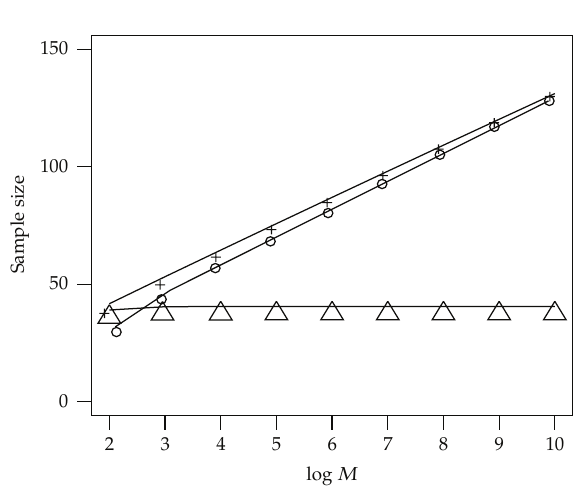
Figure 4: Sample size versus log M (cid:5) base 10 (cid:6) for controlling FDR f (cid:8) 5% with Ψ (cid:8) 90%. The open circles represent the sample sizes needed when the number of true alternatives m 1 stays as constant (cid:5) m 1 (cid:8) 40 (cid:6) , the plus signs give the sample sizes when m 1 (cid:8) 2log M , and the triangles are the sample sizes when the proportion of true alternatives is constant (cid:5) m 1 (cid:8) M/ 10 (cid:6)